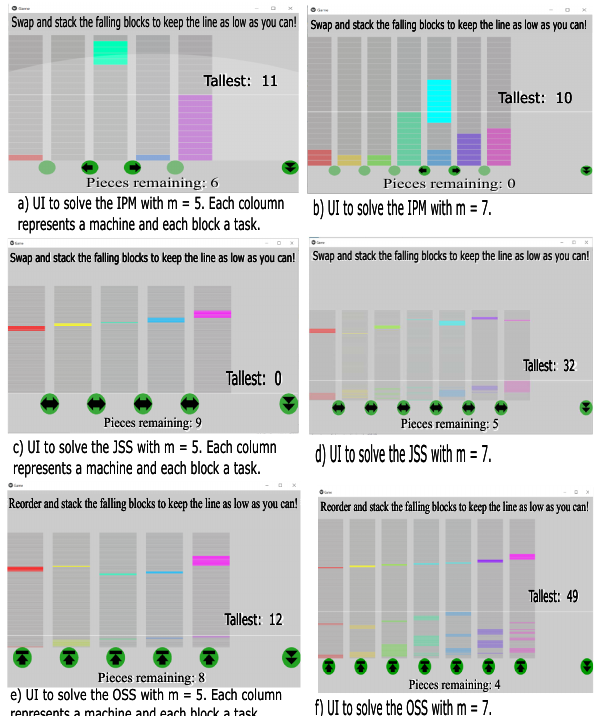
Figure 1. User interface for the scheduling game. Here, ( a , b ) show the Identical Parallel Machines variant; ( c , d ) the Job Shop Scheduling problem variant; and, finally, ( e , f ) show the Open Shop Scheduling problem